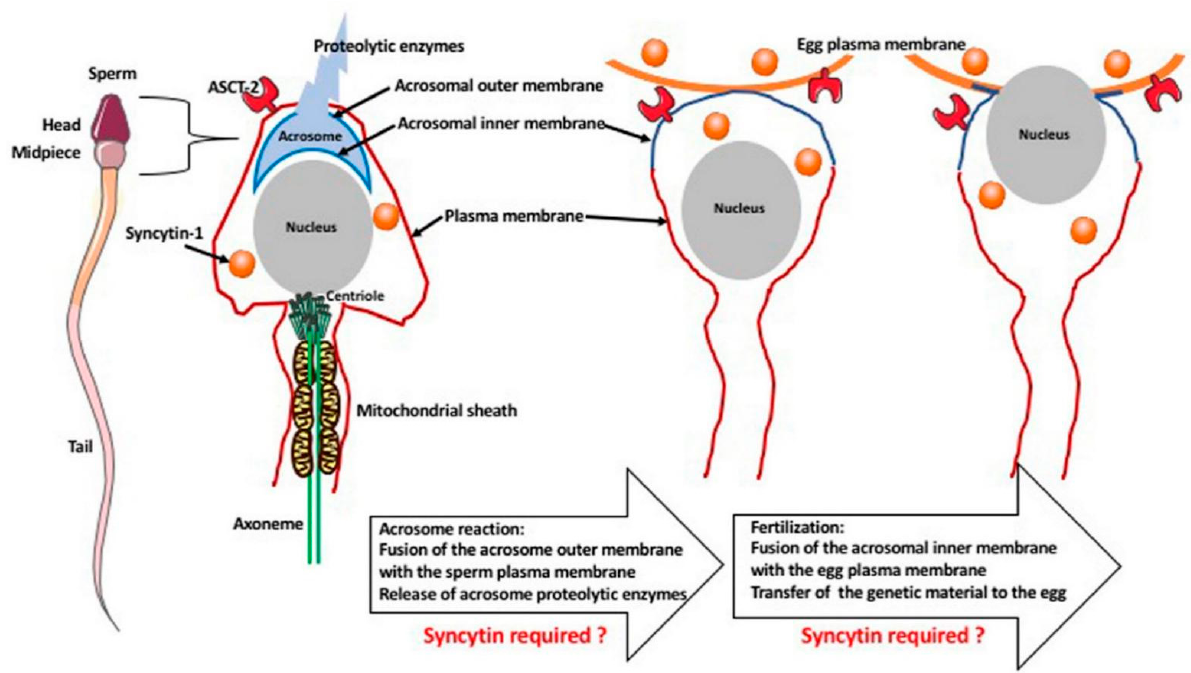
Figure 3. Membrane fusion during fertilization.